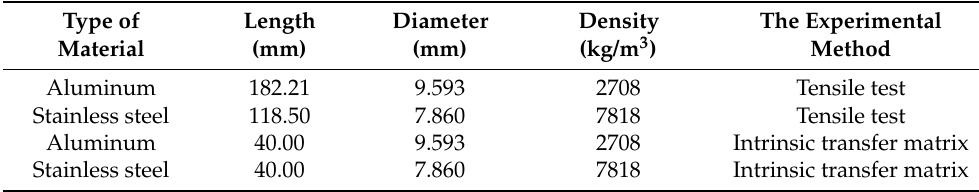
Figure 1. Types of samples for the tensile test: ( a ) stainless steel samples coded T1 (respectively T1.1 and T1.2); ( b ) aluminum sample coded T2 (respectively T2.1 and T2.2). Table 1. The physical features of the